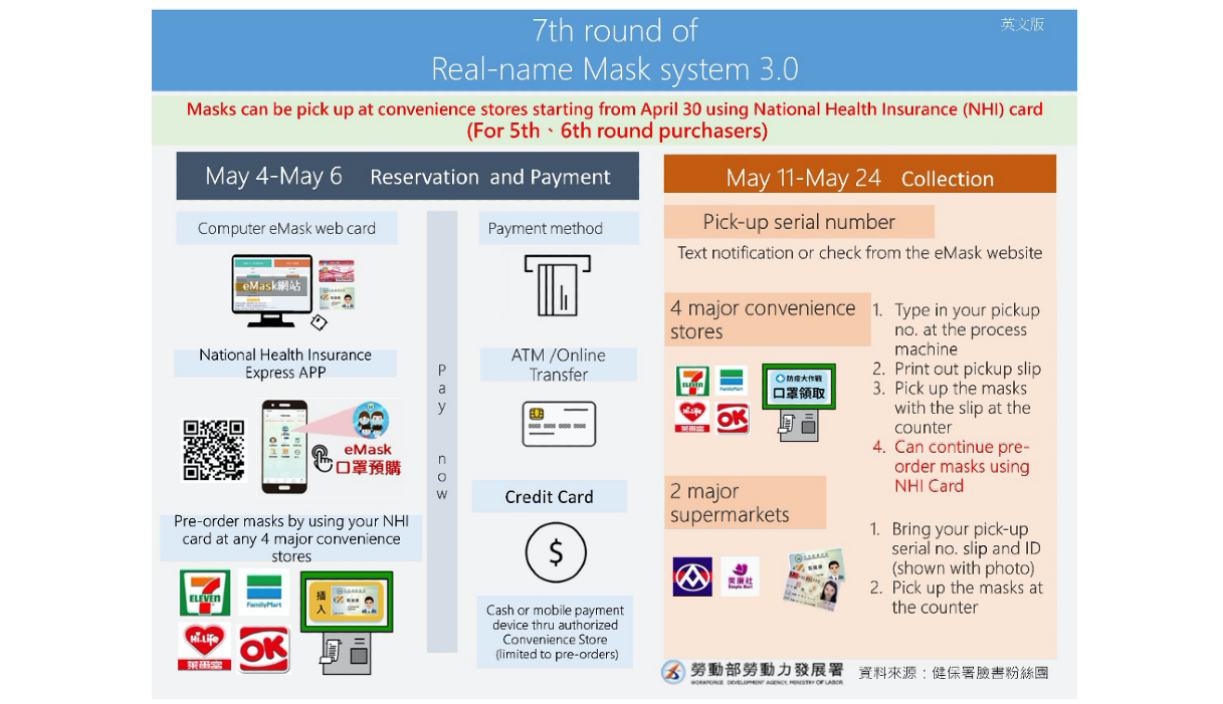
Figure 4. Mask rationing plan 3.0. Adults may purchase 9 masks in a 2-week period, while 10 masks can be purchased for children in a 2-week period. Masks can be purchased via mobile phones or from machines located in convenience stores (the typical transaction time is 1 minute). Masks can be sent